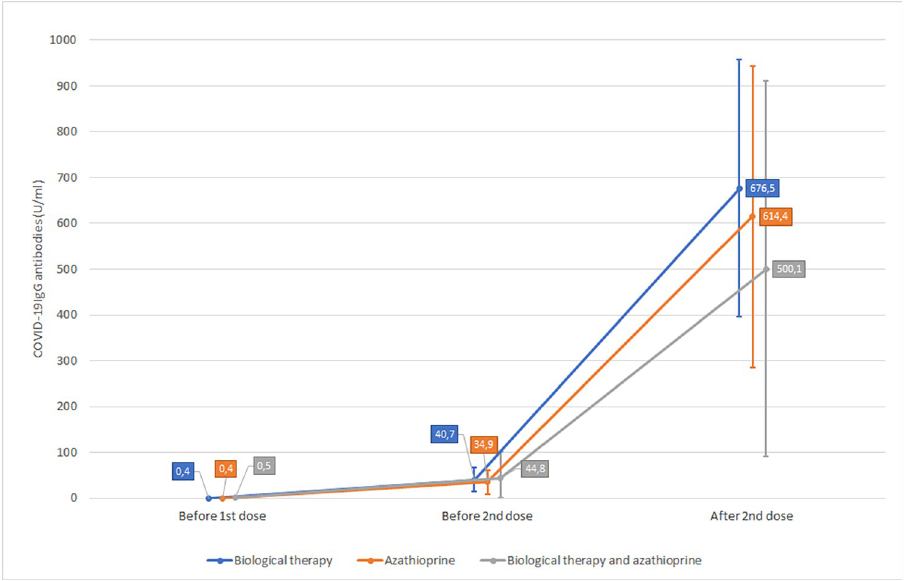
Fig 1. Comparison of IgG antibodies values (geometric means) against SARS-CoV-2 in all 3 groups of patients.